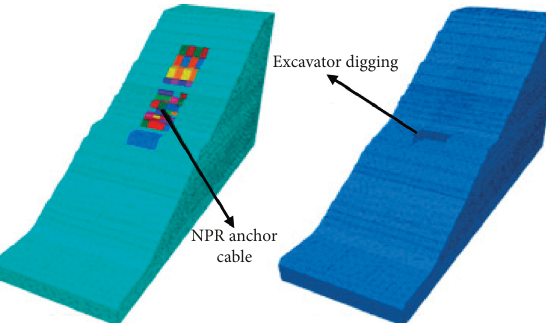
Figure 23: Double-sliding model created by 3DEC.